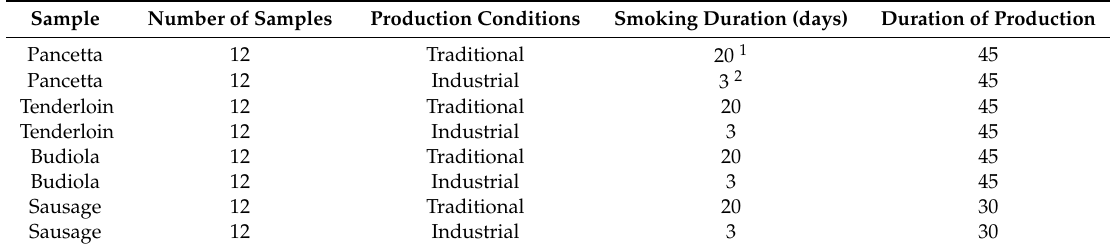
Table 1. Experimental conditions during smoking procedures of pork meat